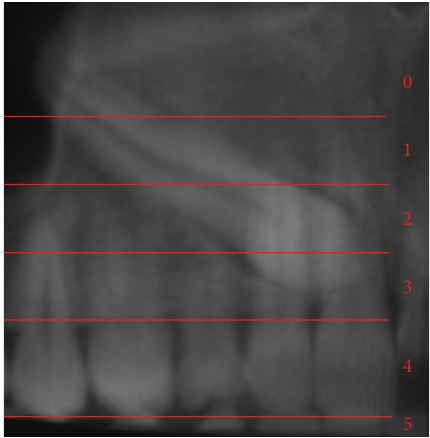
Figure 3: Vertical position (𝑦) for root tip; Panorex view. In this example 𝑅 𝑦 = 0 .